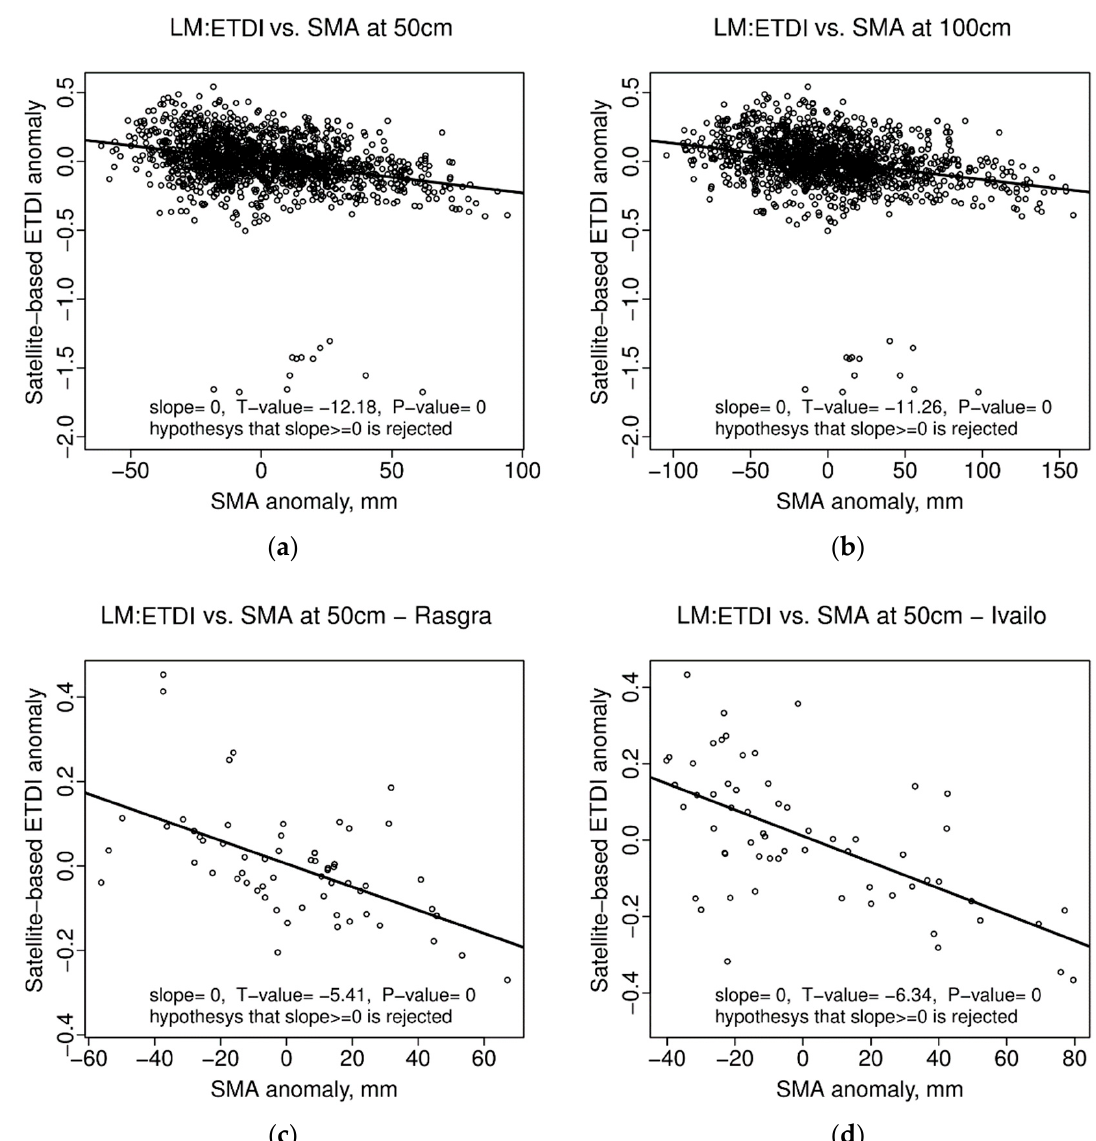
Figure 11. Descending linear regression models of the relationship between satellite-derived ETDI anomalies and SMA anomalies: ( a ) all 26 synoptic stations in Bulgaria at 50 cm soil depth; ( b ) all 26 synoptic stations in Bulgaria at 100 cm soil depth; ( c ) a station in north Bulgaria; ( d ) a station in south Bulgaria. The monthly mean (2011–2021) was used to calculate the anomalies.